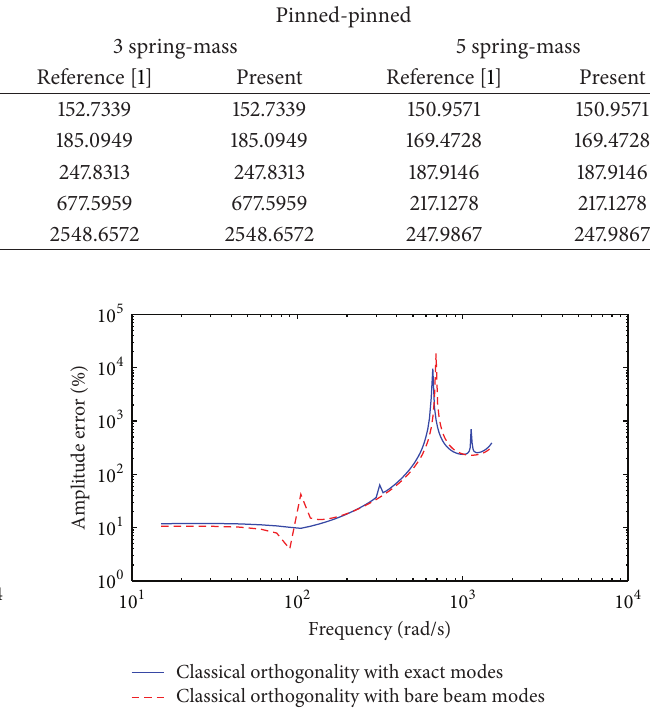
Figure 4: Time history of the free-end vertical displacement for a cantilevered beam carrying three mass-spring-damper systems for a forcing frequency Ω = 10 rad/s, 𝑘 = 0.1 N/m, 𝑇 = 0 , 𝑀 𝑑 = 0.1 kg, = 0 kg, 𝑐 = 0.1 Ns/m, and 𝐿 = 0.1 , 0.5, 0.9 m. 𝑀 𝑐 𝑑 1;2;3